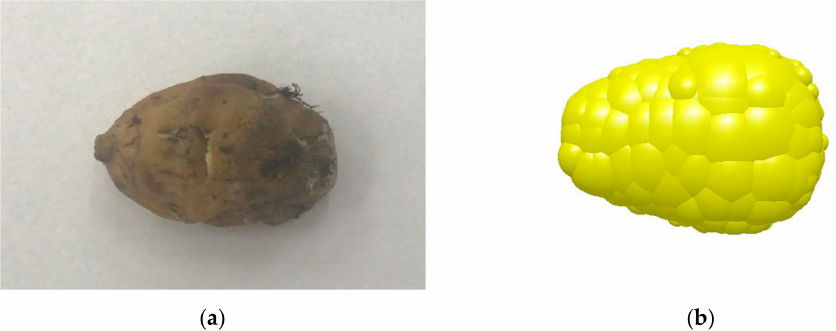
Figure 8. Discrete element model of Cyperus esculentus tuber. ( a ) Cyperus esculentus tuber model; ( b ) discrete element modeling of Cyperus esculentus